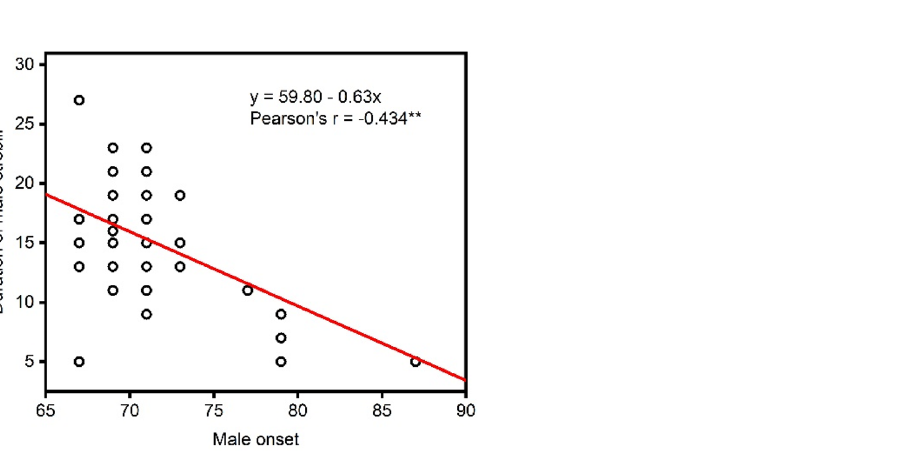
Figure 3. Date of male onset versus duration of pollen shed in seed orchards. **Indicates significant difference at the level of